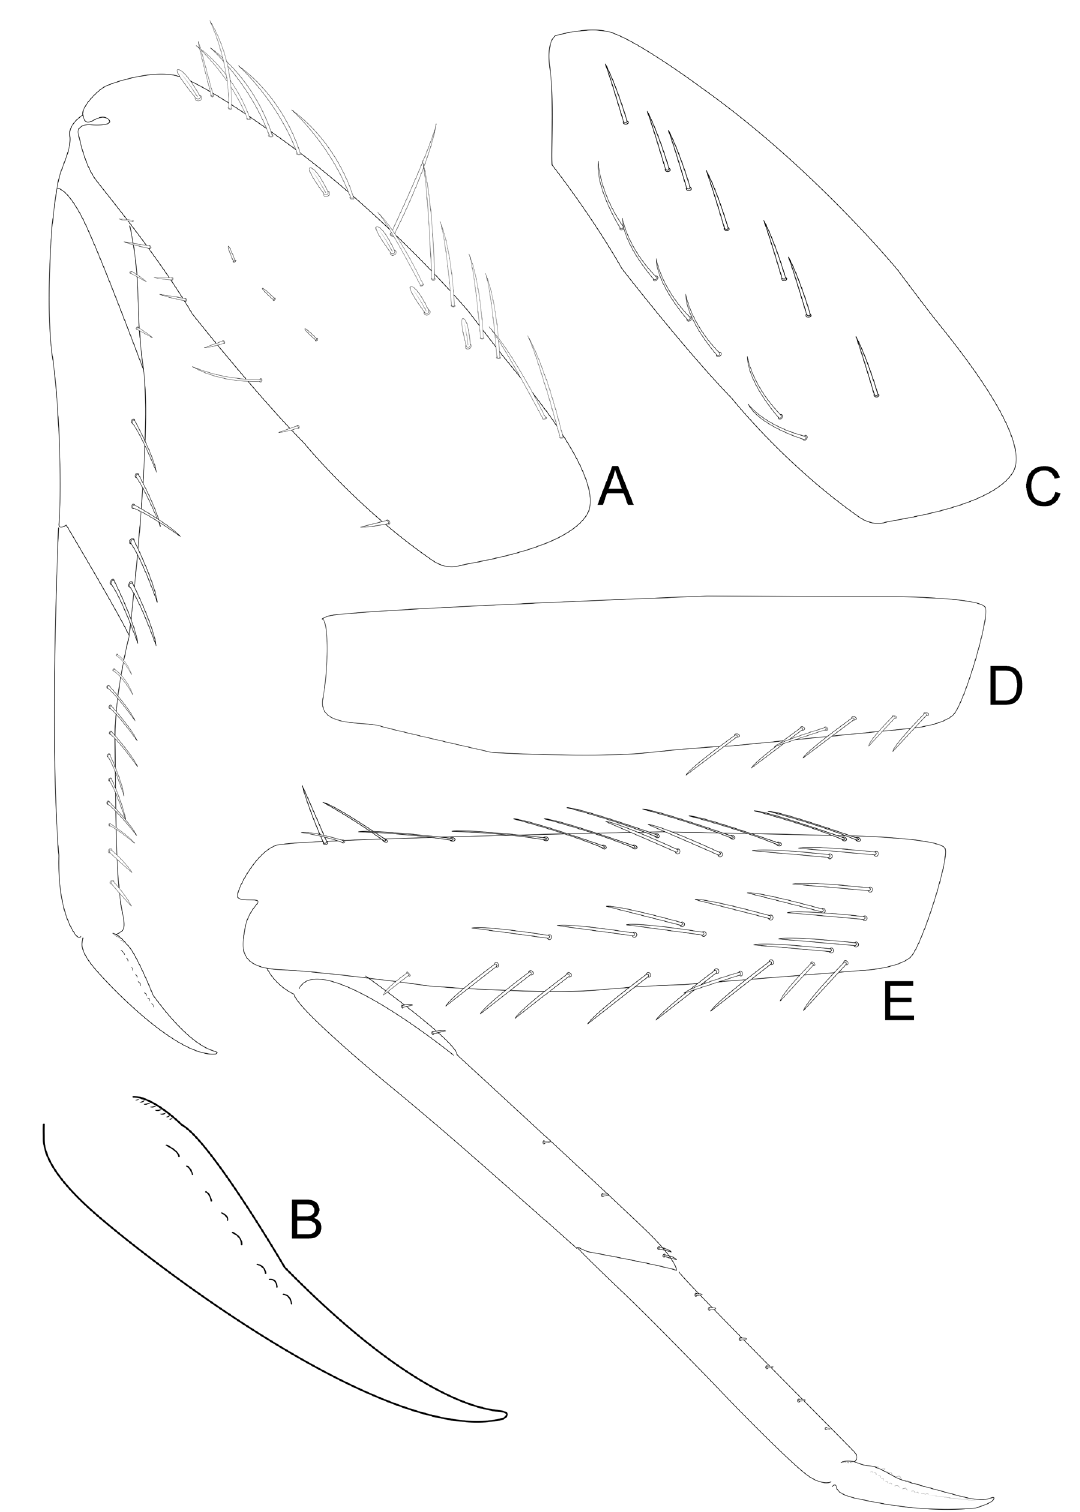
Fig. 17. Rivudiva naia sp. nov., holotype (UFRR). A . Foreleg (femur on anterior surface). B . Detail of fore claw. C . Posterior surface of forefemur. D . Posterior surface of hind femur. E . Hind leg (femur in anterior surface). Not to